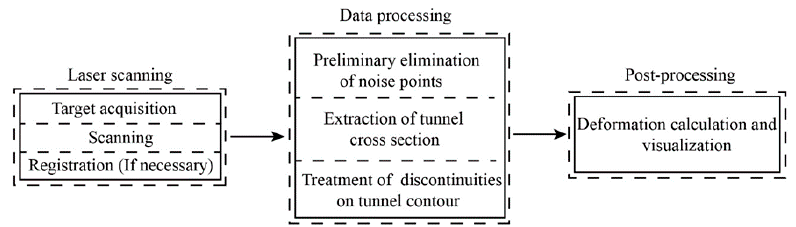
Figure 1. Workflow of the application of TLS on tunnel lining loading test.